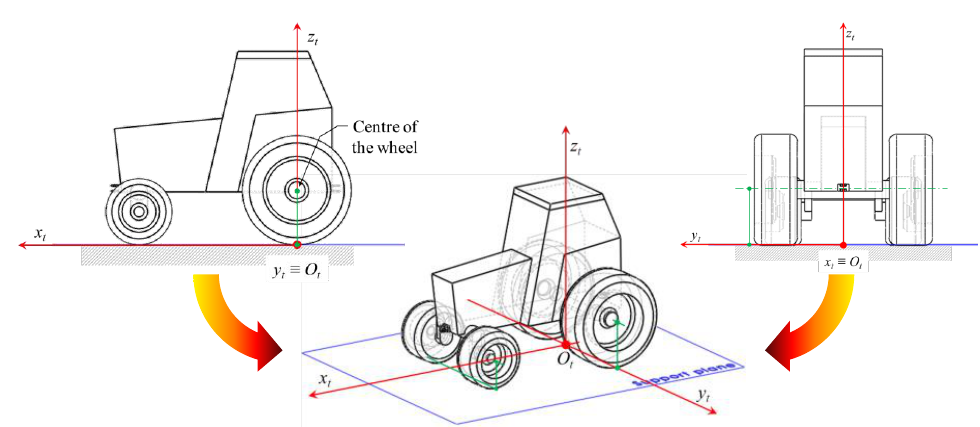
Figure 6. Placement of the tractor frame of reference.